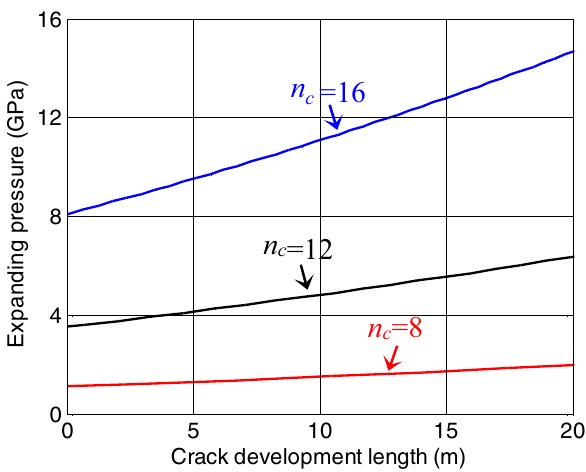
Fig. 3 The development characteristics of fractures with diameters of